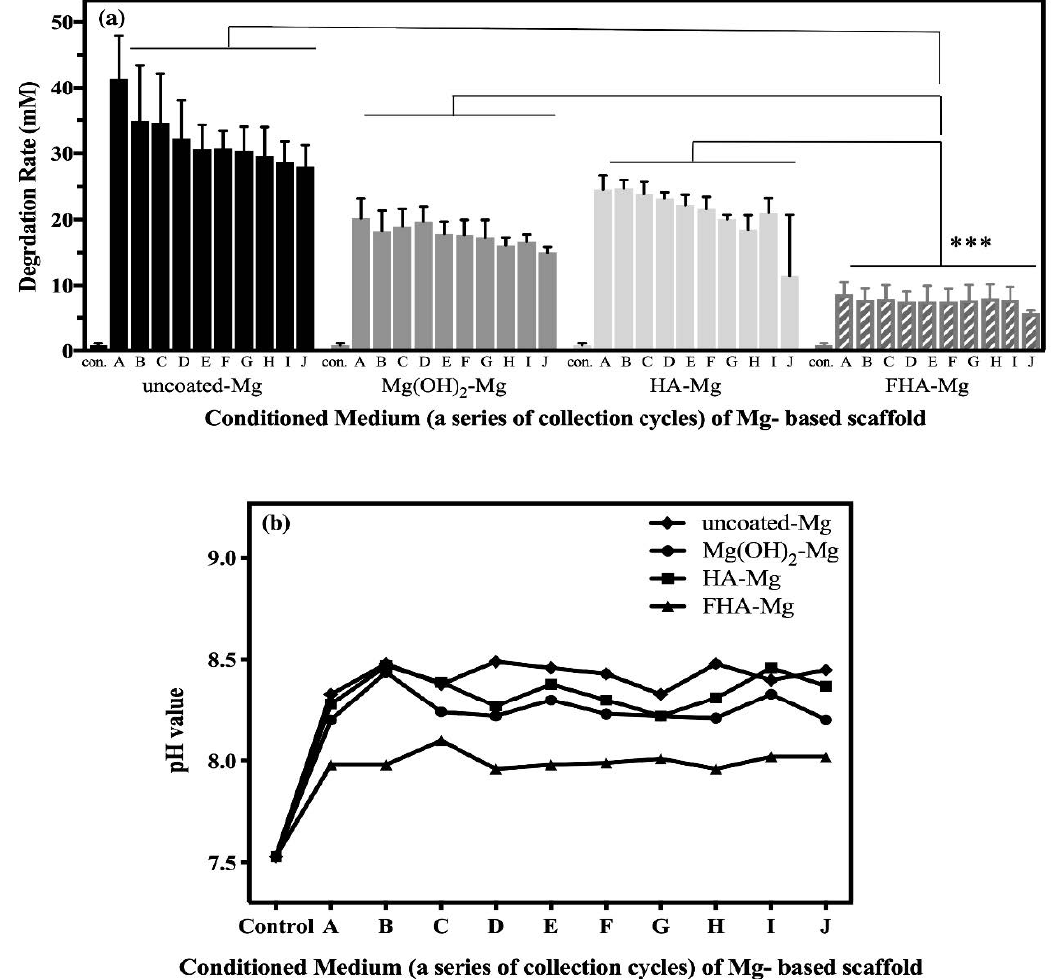
Figure 2. ( a ) The concentrations of released Mg 2+ ions. Values shown are mean ± standard error ( n = 3). *** p < 0.001 between FHA-Mg group and each of the other three groups. ( b ) The pH values of different Mg 2+ conditioned